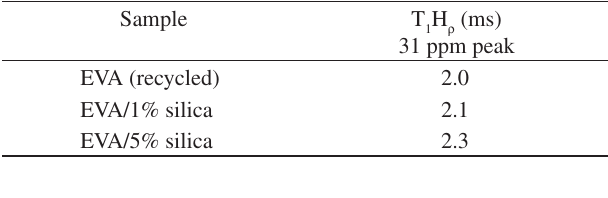
Table 3. Proton T